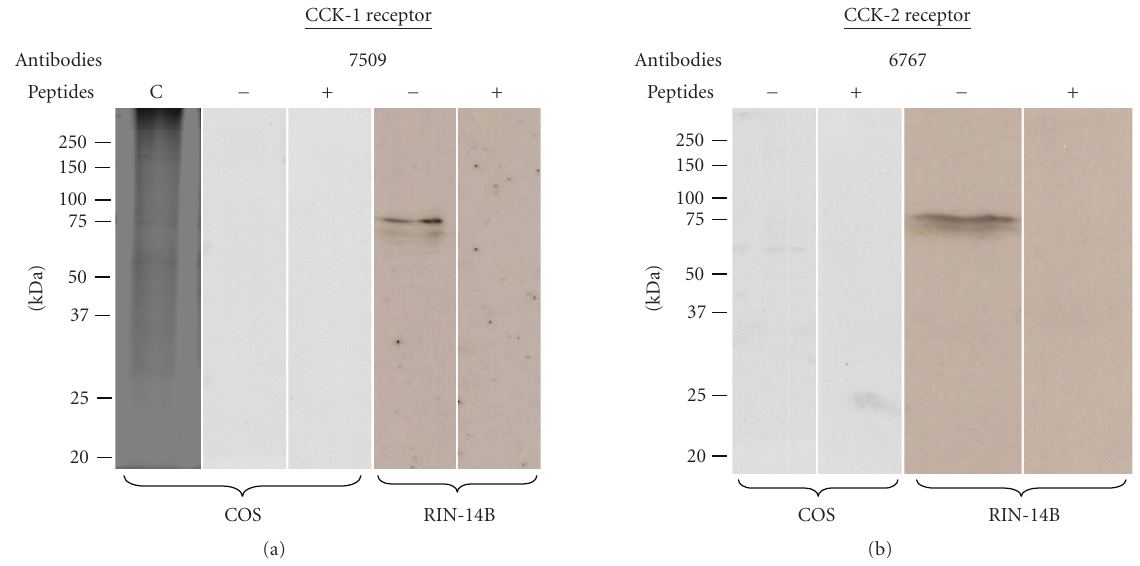
Figure 1: Specificity of the CCK-1 and CCK-2 receptor antibodies established by Western blotting. Membrane from the RIN-14B and COS cells (100 μ g) were used for Western blotting analysis with antibodies 7509 (0.1 μ gmL − 1 ) and 6767 (0.1 μ gmL − 1 ). Specificity was established by preincubation of each primary antibody for 2 hours at RT with each receptor-specific peptide antigen (1 μ gmL − 1 of 7509 and 0.1 μ gmL − 1 of 6767 peptides). C: blue Coomassie gel coloration.